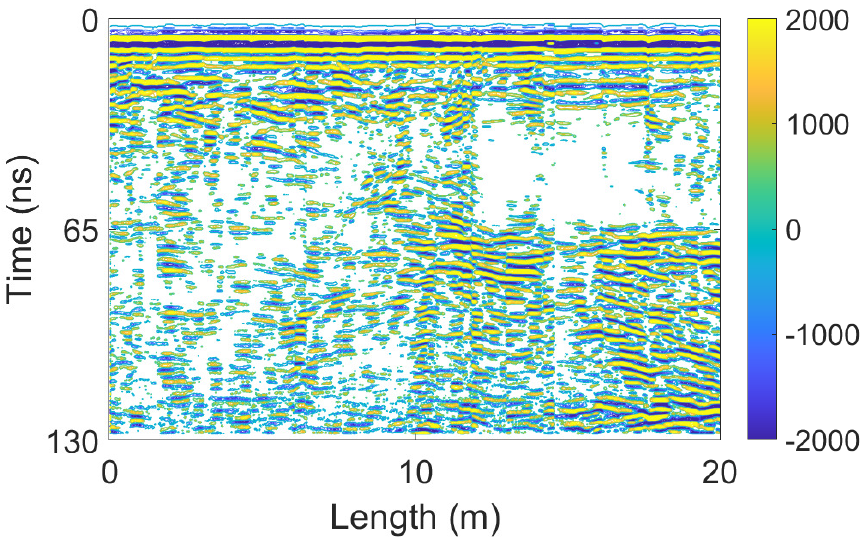
Figure 16. The pre-processed radargram from an example surrounding rock section. Signals weaker than 2.5% of the maximum amplitude are